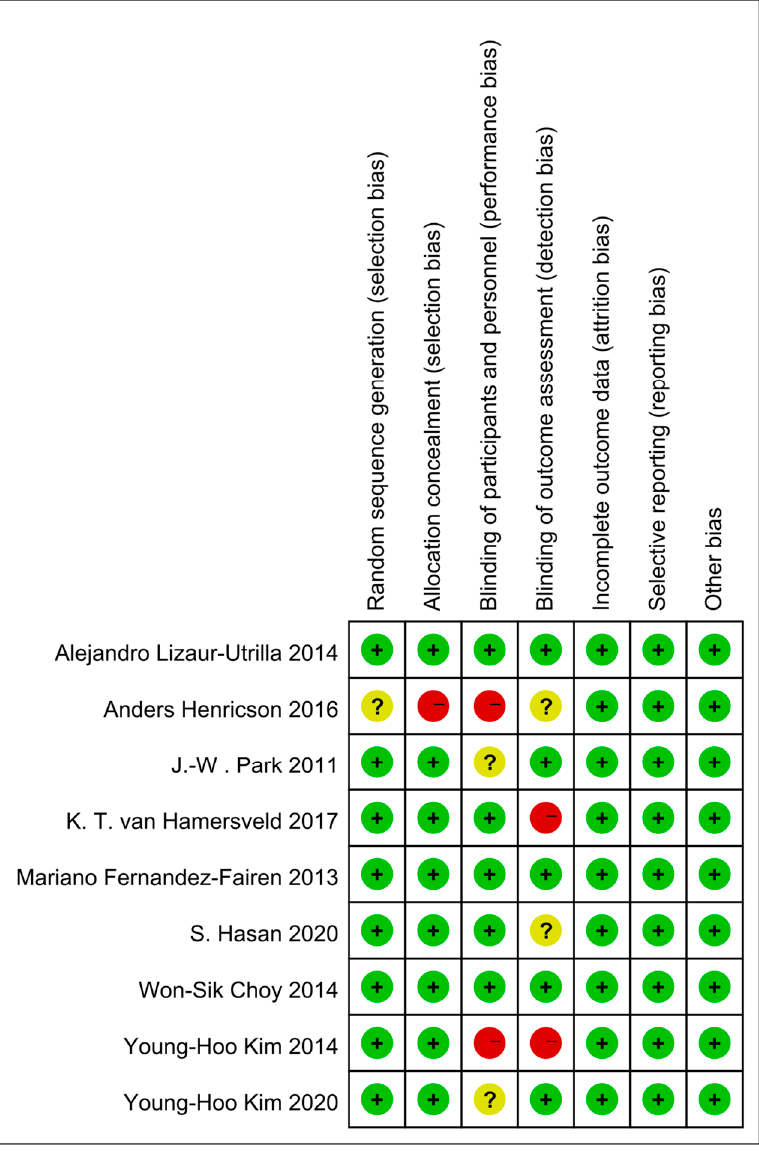
Figure 2. Risk of bias summary [23–31]. “+”: Low risk of bias; “ − ”: High risk of bias; “?”: Unclear risk of bias. Table 1. Characteristics of the studies included in the meta-analysis. Abbreviations: C: cemented; UC: uncemented; CR: cruciate-retaining; PS: posterior-stabilized; KSS: Knee Society Score; ROM: range of motion; RLL: radiolucent line; NA: not available.